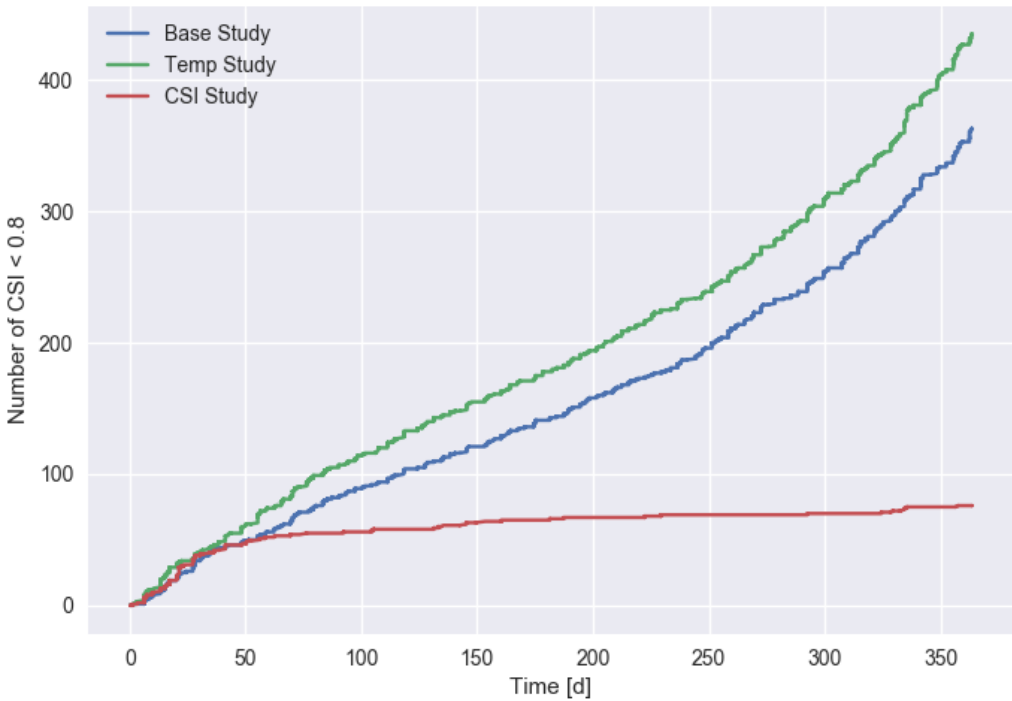
Figure 11. Accumulated number of low (<0.8) CSI charging processes for different scenarios (with P Base = 30 kW).